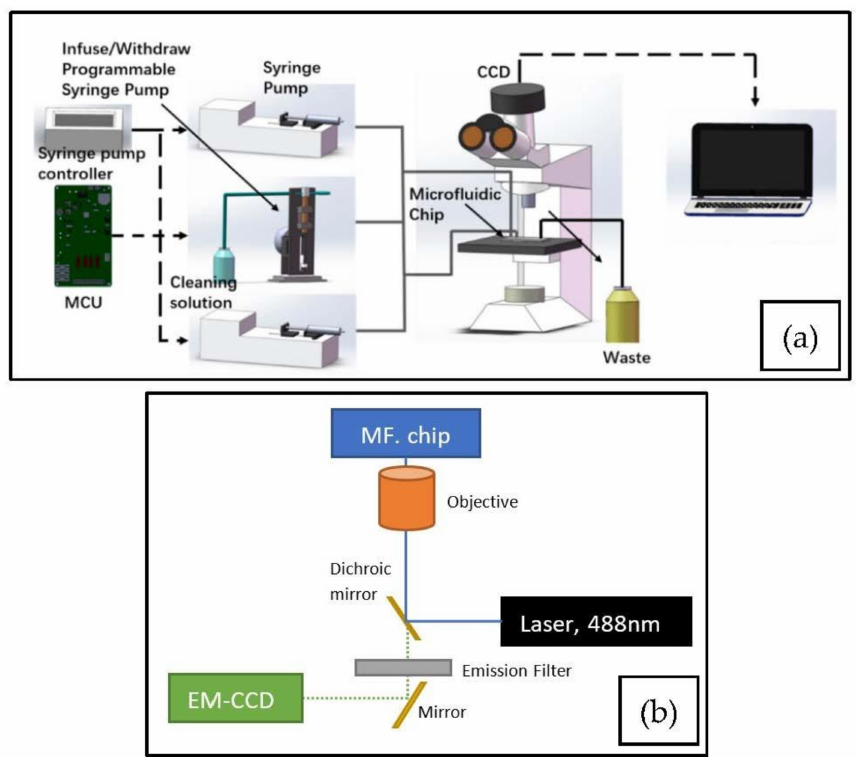
Figure 5. Detection setups used in droplet microflow cytometry (DMFC) using Charge Coupled Device (CCD) sensors as a detector. ( a ) A typical solution for microscope-based microfluidic measure- ment setup. A microscope with an integrated camera is used to zoom and focus on a microfluidic chip. Two syringe pumps with a controller are responsible for the continuous flow of sheath (carrier) fluid and sample fluid. ( b ) A laser Electron Multiplying Charge Coupled Device (EMCCD) sensor system capable of detecting fluorescence-induced droplets at the rate of 30 Hz. The optical setup consists of a 20 × objective lens, dichroic mirror, emission filter, mirror, camera, laser, and a microfluidic device. Reproduced with permission from